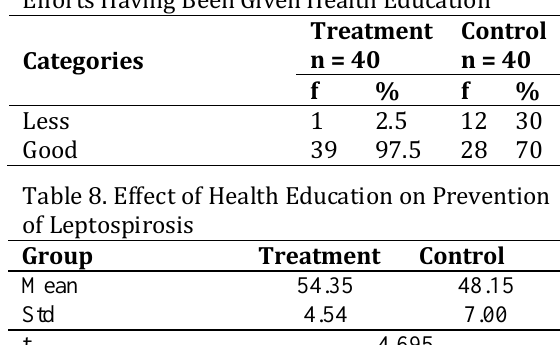
Table 7. Description of Leptospirosis Prevention